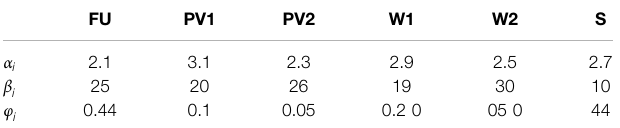
TABLE 1 | The port microgrid energy supply device